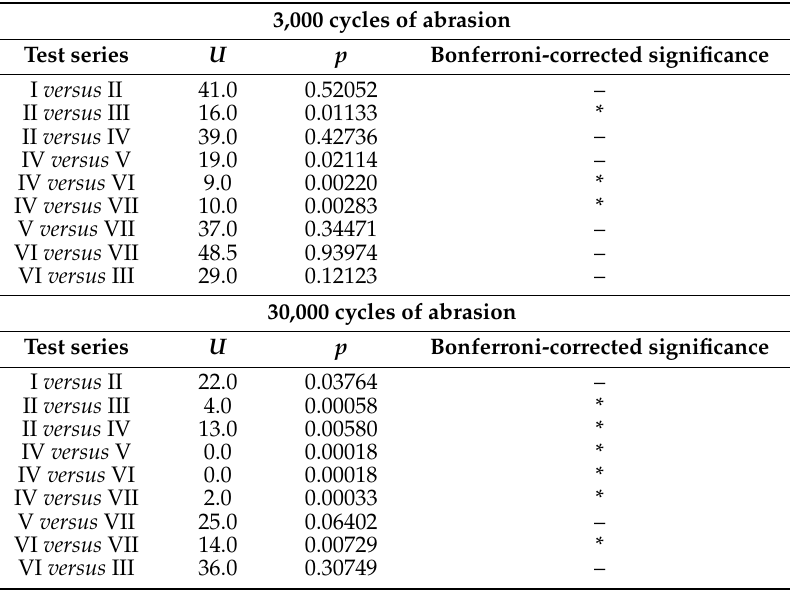
Table 6. Statistical analysis ( U -test, p = 0.05 with Bonferroni correction, p = 0.0125) of test series with respect to remaining chitosan coating on